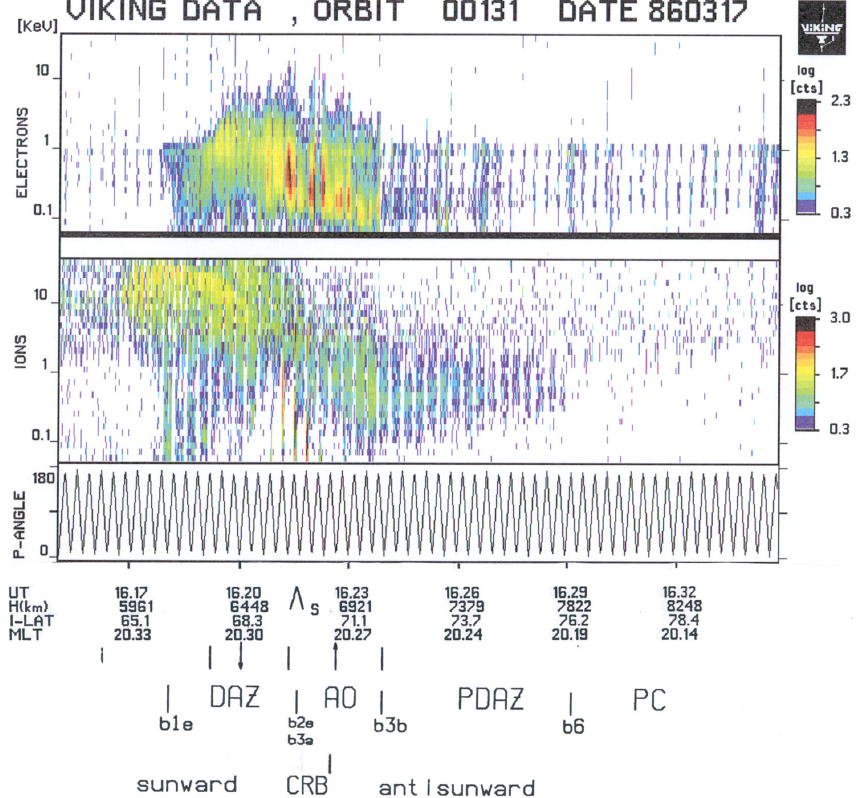
Fig. 5a. Viking particle spectrogram for orbit 131 on 17 March 1986, 1616–1727 UT. The plasma regimes and their boundaries, the convection reversal boundary (CRB) and field-aligned currents marked by arrows are given at the bottom: (a) the duskside